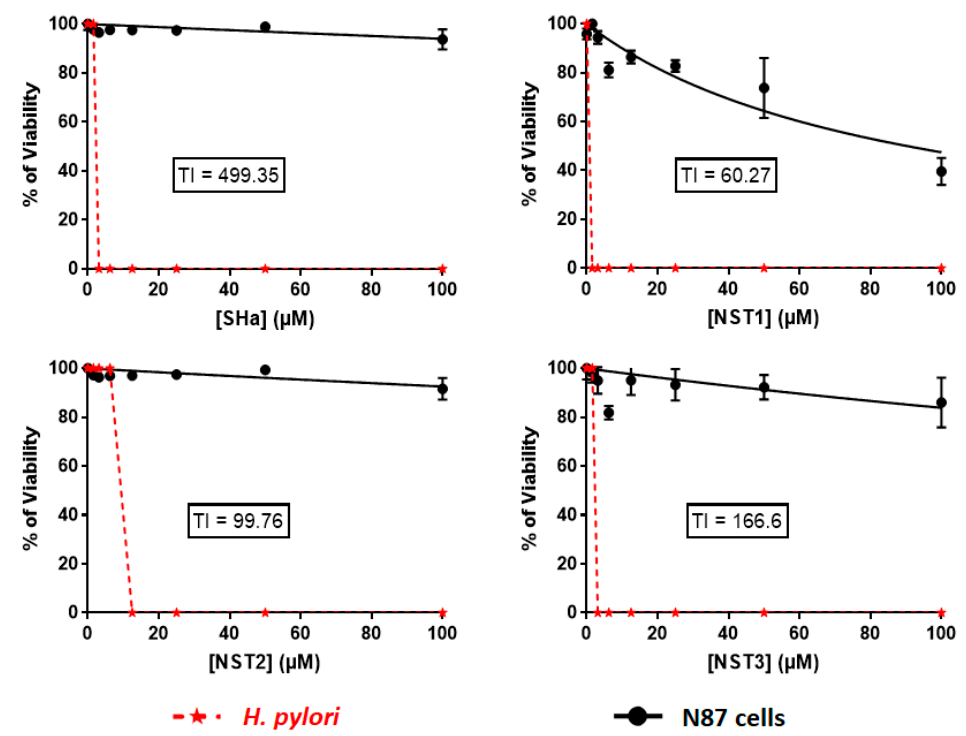
Figure 6. Evaluation of the therapeutic safety of temporin-SHa, NST1, NST2, and NST3. Dose-dependent effect of the peptides on the viability of H. pylori (ATCC 43504) and human N87 cells was measured. TI was calculated by dividing IC 50 values obtained from cytotoxicity curves on N87 by MIC values obtained with H. pylori (ATCC 43504).